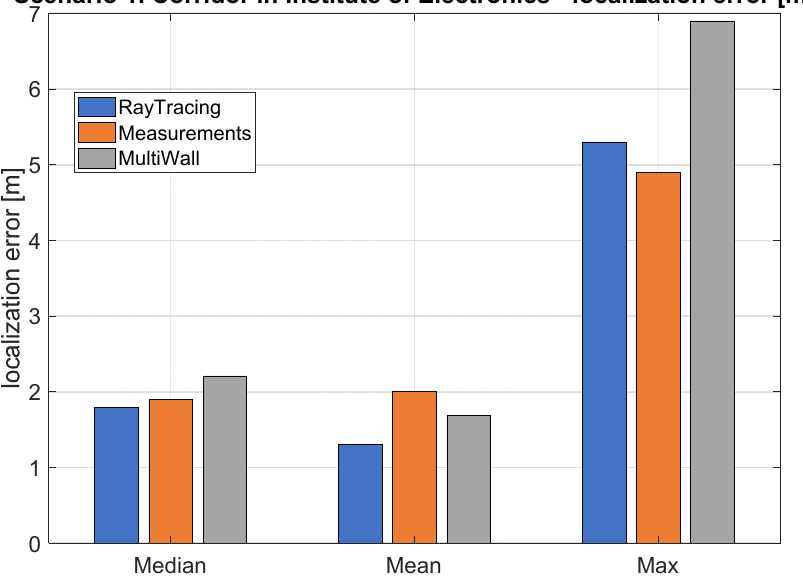
Figure 16. Localization error in scenario 1 (corridor in the Institute of Electronics, Lodz University of Technology). Data obtained using reference RSSI datasets prepared by different methods. The second scenario (S2) produced similar results. The smallest median error and lowest mean error were measured for the ray tracing method (Figure 17). In this scenario, the highest maximum error occurred for the multiwall model.